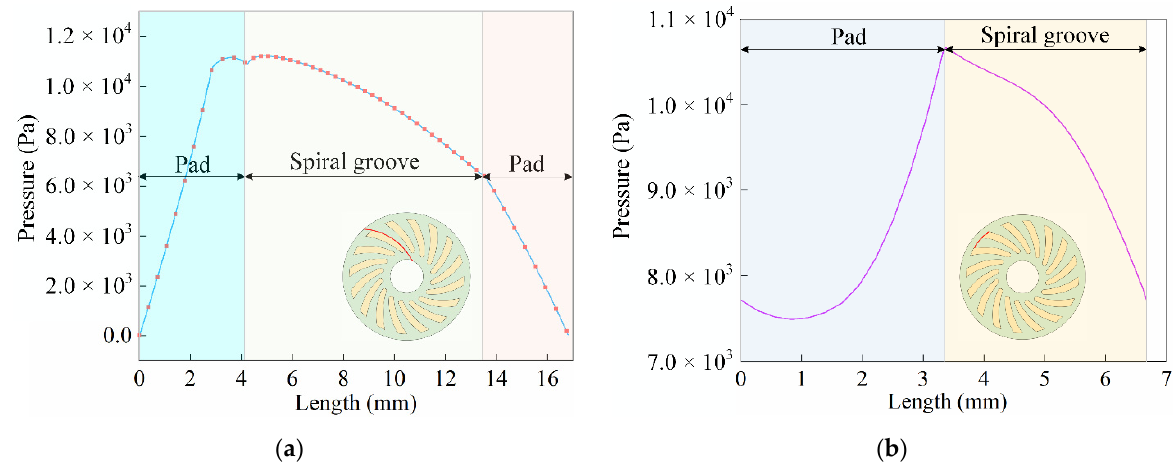
Figure 12. Pressure distribution of the hydrodynamic bearing: ( a ) Radial pressure distribution; ( b ) Circumferential pressure distribution.